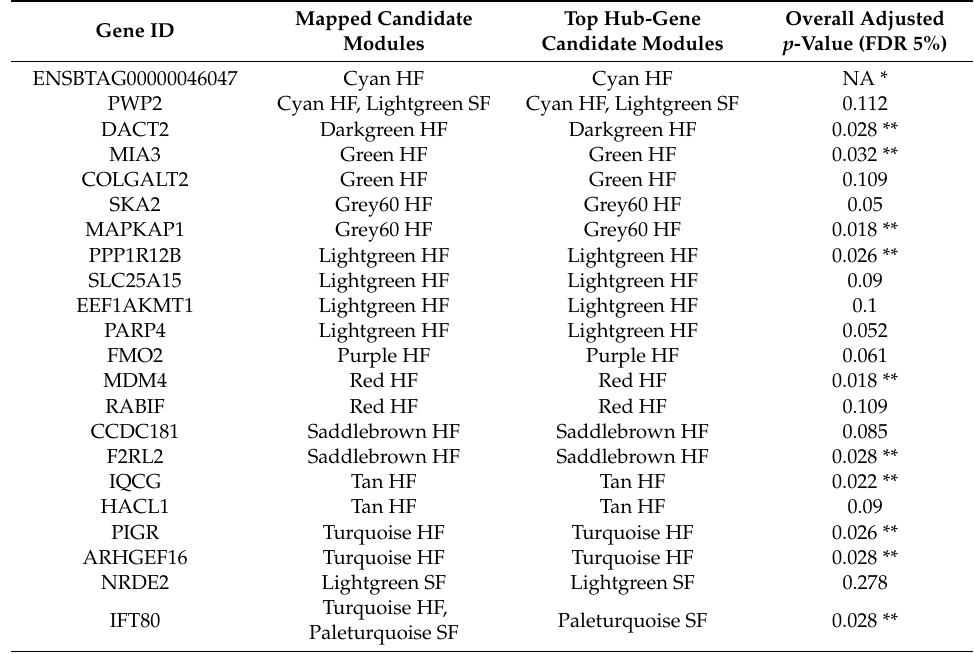
Figure 4. Percentage of each functional consequence annotated (A) and number of fixed variants per each functional candidate gene (B). The red bars in B represent genes where the fixed variants were identified in sub-fertile animals, while the green bars represent those variants fixed in high-fertile animals.